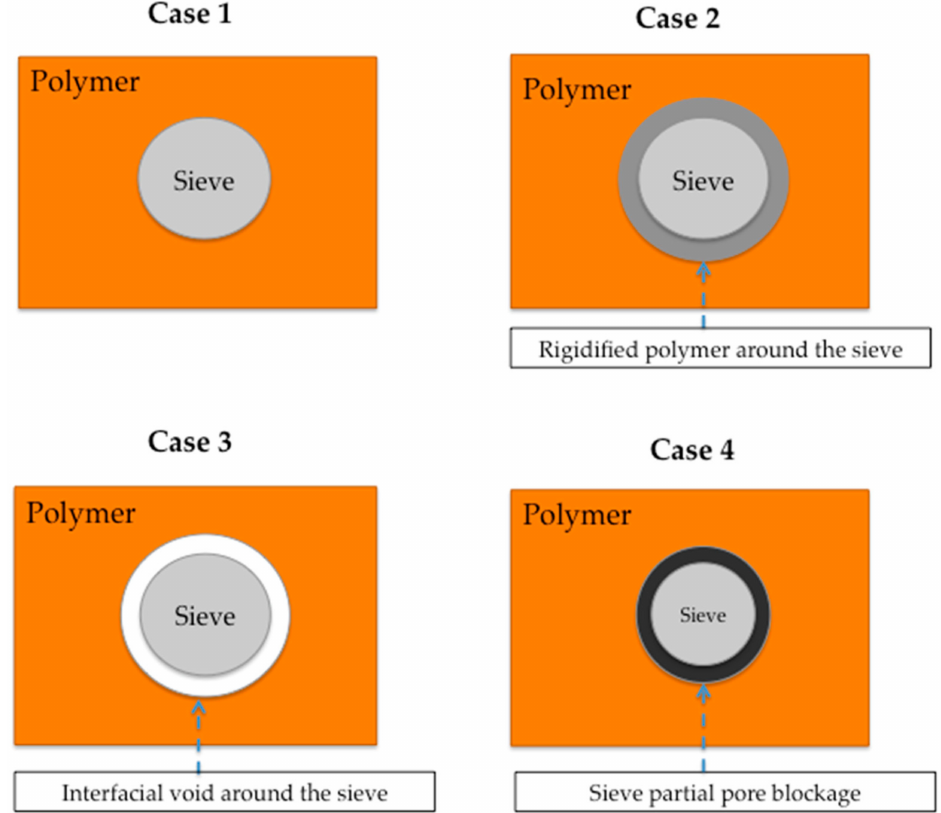
Figure 6. General description of different structures at the polymer–zeolite interface region